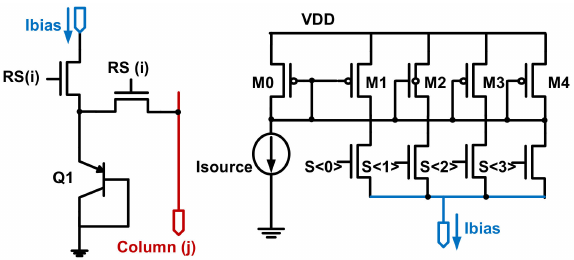
Figure 4. Schematic of in-pixel bipolar junction transistor (BJT)-based temperature sensor and its current biasing with DEM. M0~M4 are in practice cascode